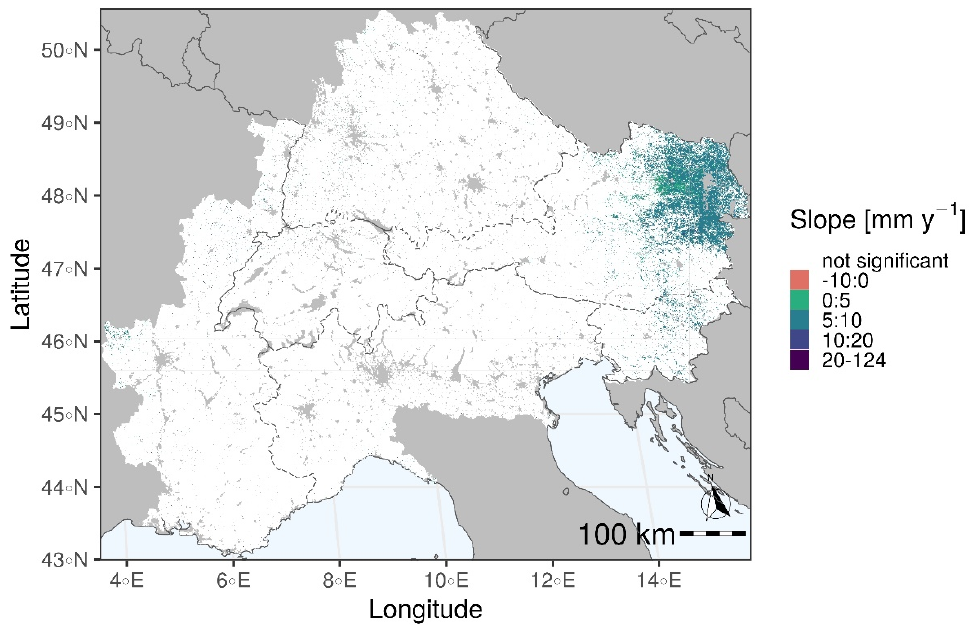
Figure 6. Sen’s slope of the trend at 5% significance level for yearly PET. The period of investigation is 2003–2019.